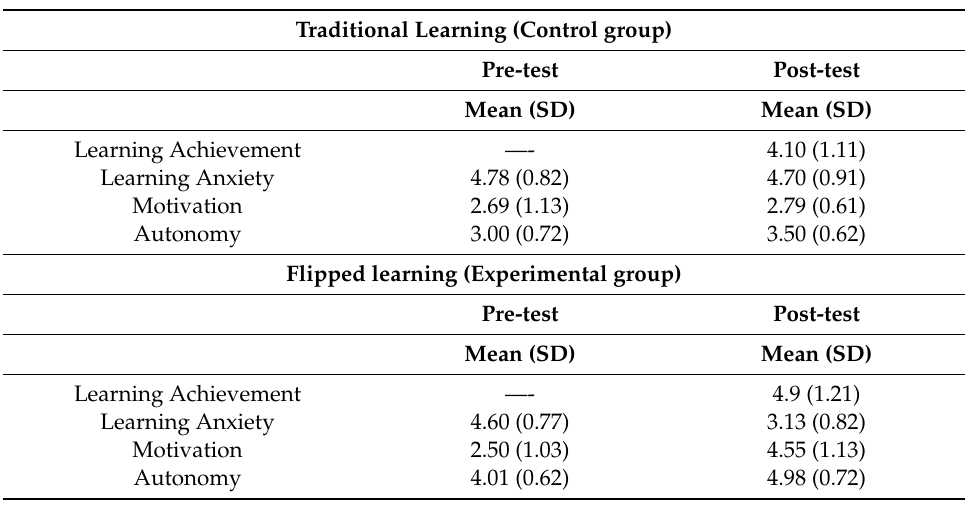
Table 3. Descriptive analysis of each dimension in two kind of